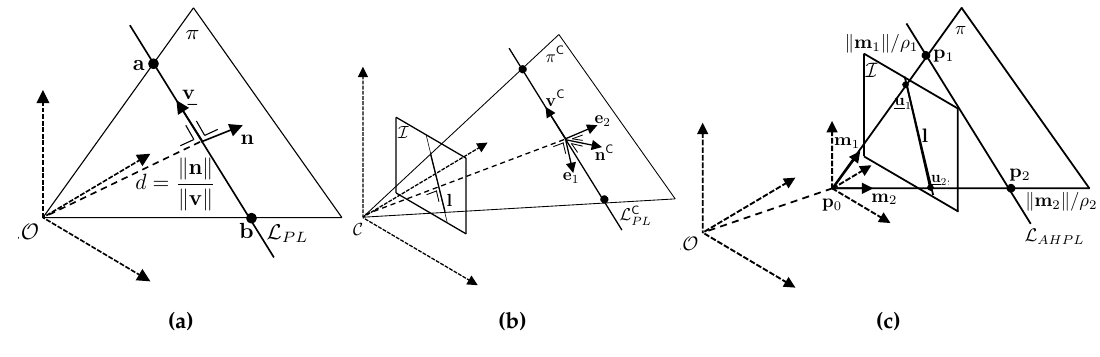
Figure 2: Pl¨ucker line geometrical representation. Image extracted from [ ? ]